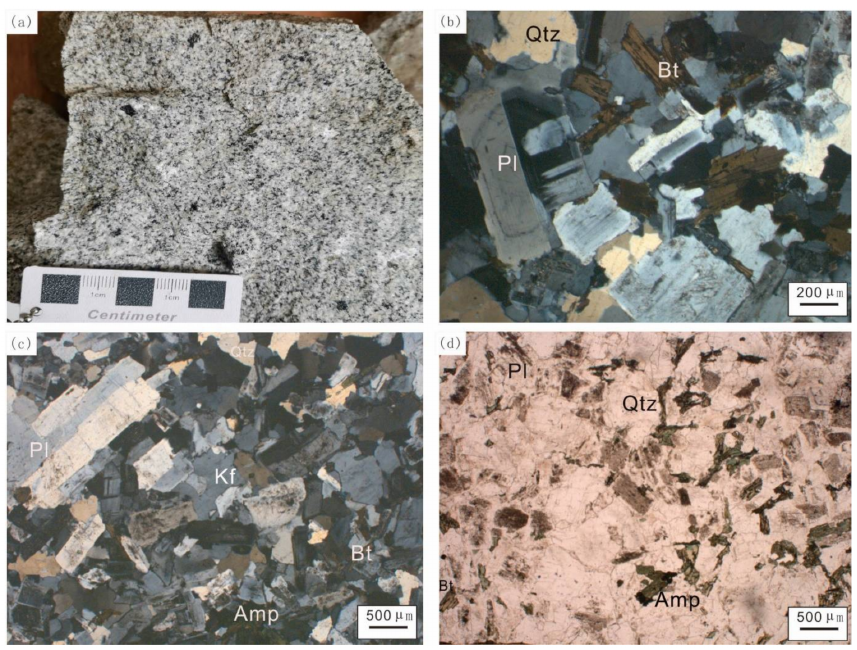
Figure 2. The petrographic characteristics of the Zhouguan granodiorite. ( a ) Granodiorite hand specimen; ( b – d ) photomicrographs of granodiorite showing the main rock-forming minerals of quartz (Qtz), plagioclase (Pl), K-feldspar (Kf), biotite (Bt), and amphibole